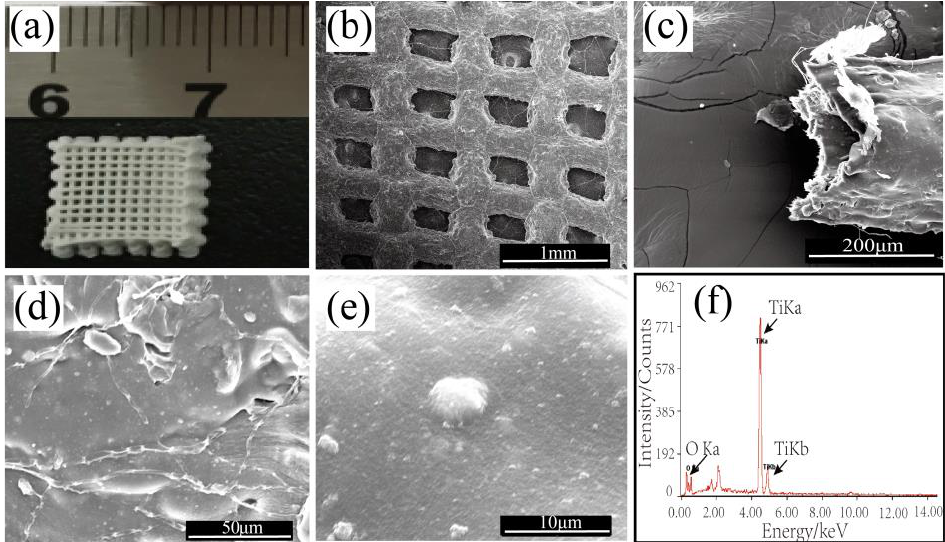
Figure 1. Photograph ( a ) and SEM images of the TiO2/chitin/cellulose photocatalyst with a magnification of 100× ( b ), 2000× ( d ), and 10,000× ( e ). ( c ) shows the hollow structure of the printed strands. ( f ) is one EDS spectrum for the strand surface, which indicates the presence of an abundance of titanium compounds.